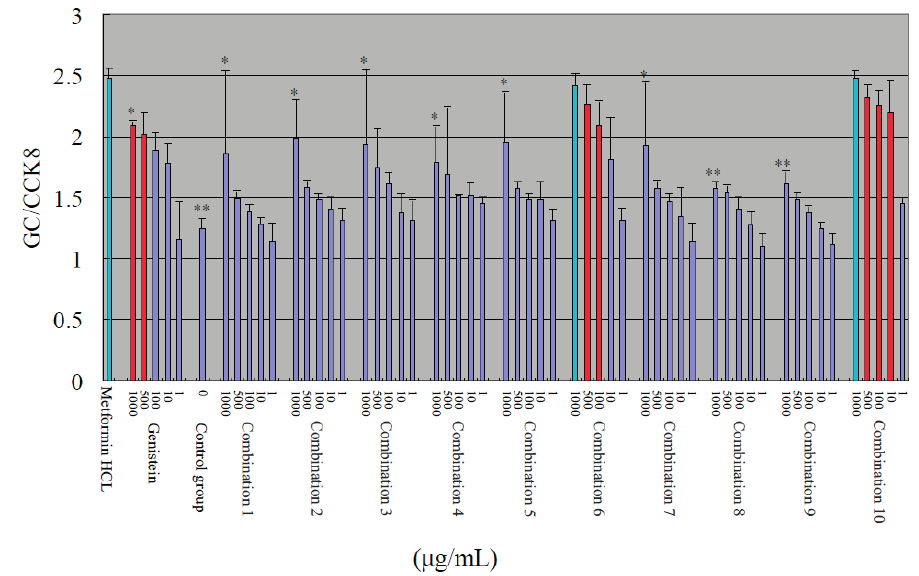
Figure 4. Hypoglycemic activities of combinations. The differences between combination 6, combination 10 and other combinations were statistically significant ( p < 0.05 or p < 0.01, denoted by “*” or “**”,